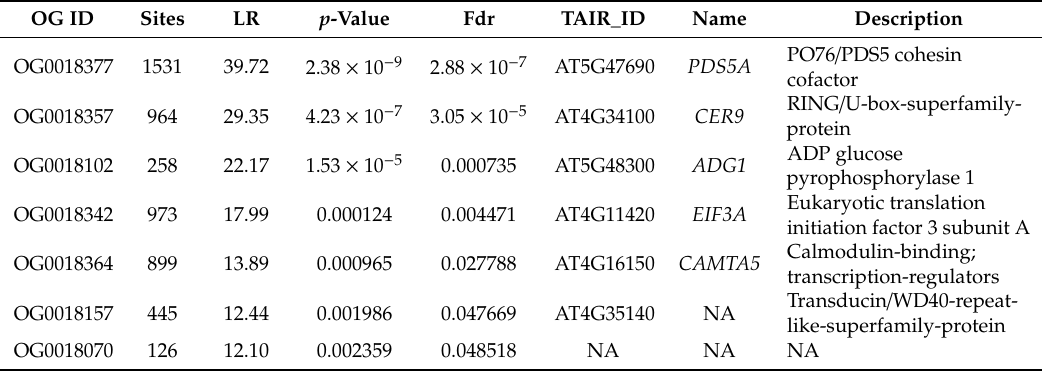
Table 2. Homology-based functional annotation of the 7 genes under positive selection after multiple test correction (FDR: 0.05) according to the sequence alignment-wide method implemented in